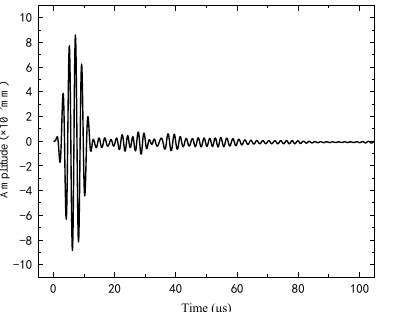
Figure 6. Time domain received signal when the maximum mesh grid is 10 mm.